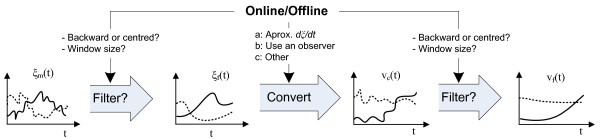
Conversion of measured concentrations to measured fluxes. First, the measured concentrations should be filtered. Then, fluxes are calculated from the concentration data (e.g. approximating the derivative or using a dynamic observer). Finally, the calculated fluxes may be filtered to get a smooth signal. Each step is conditioned by the operation mode (on-line or off-line).